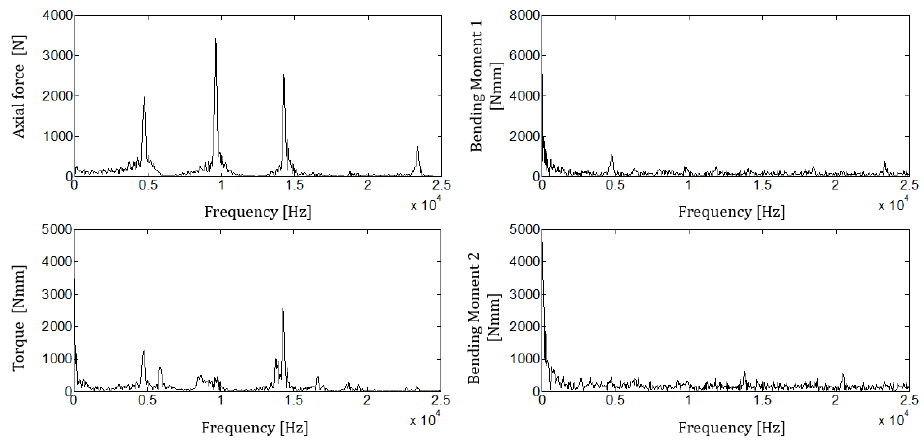
Figure 9. Axial force and torques spectra of a single blow, test IDN 020.